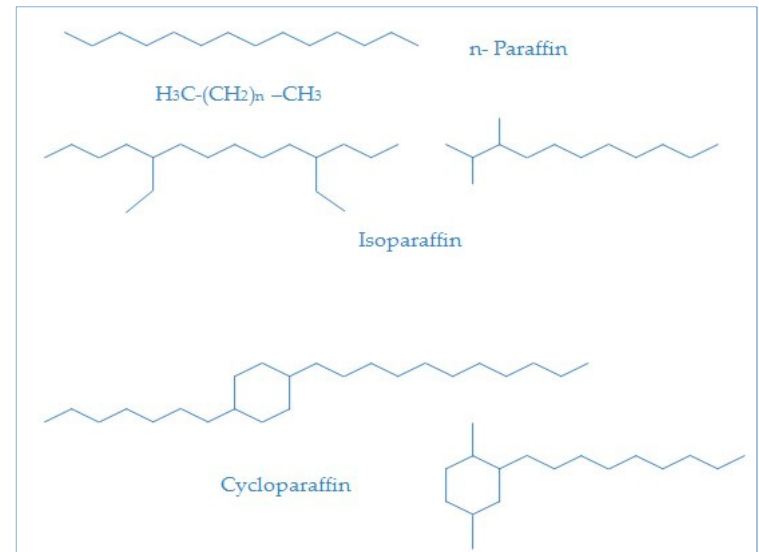
Figure 2. The paraffin structure.